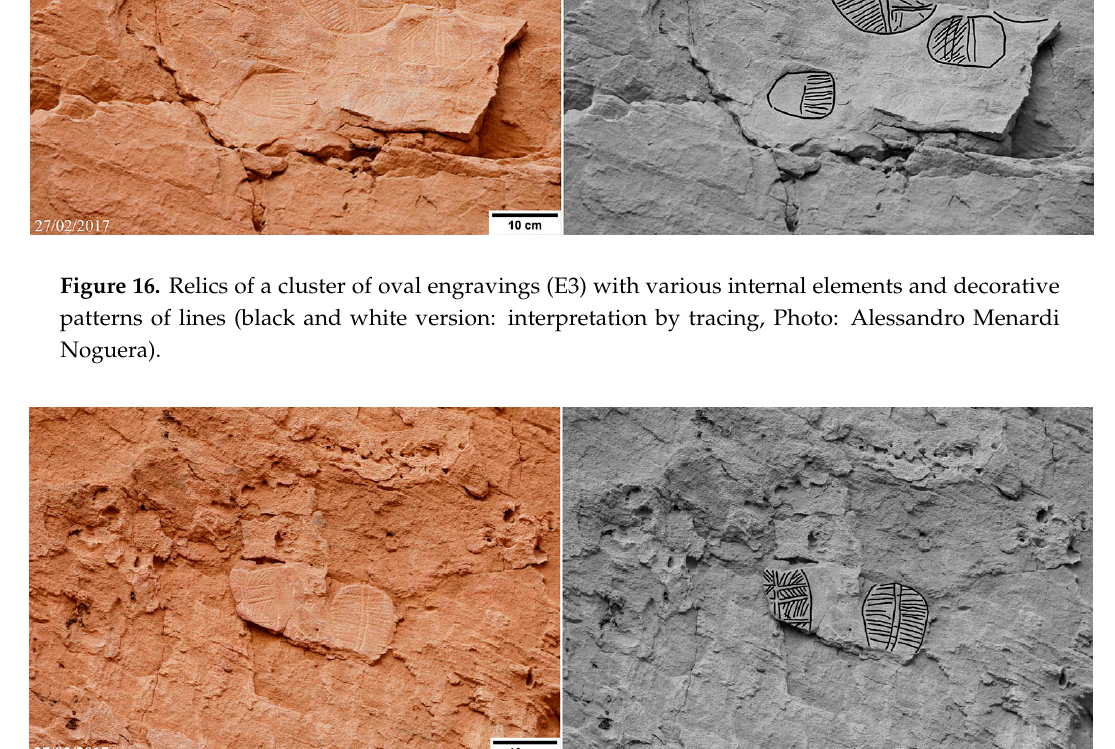
Figure 17. Two paired oval engravings (E4), one with an internal graphic element recalling a framework, the other with a longitudinal element (black and white version: interpretation by tracing, Photo: Alessandro Menardi Noguera). symmetry, up right ‐ to ‐ left, decorated the right part, as can be deduced by the narrow strip of engraved rock still preserved to the right of the longitudinal element.